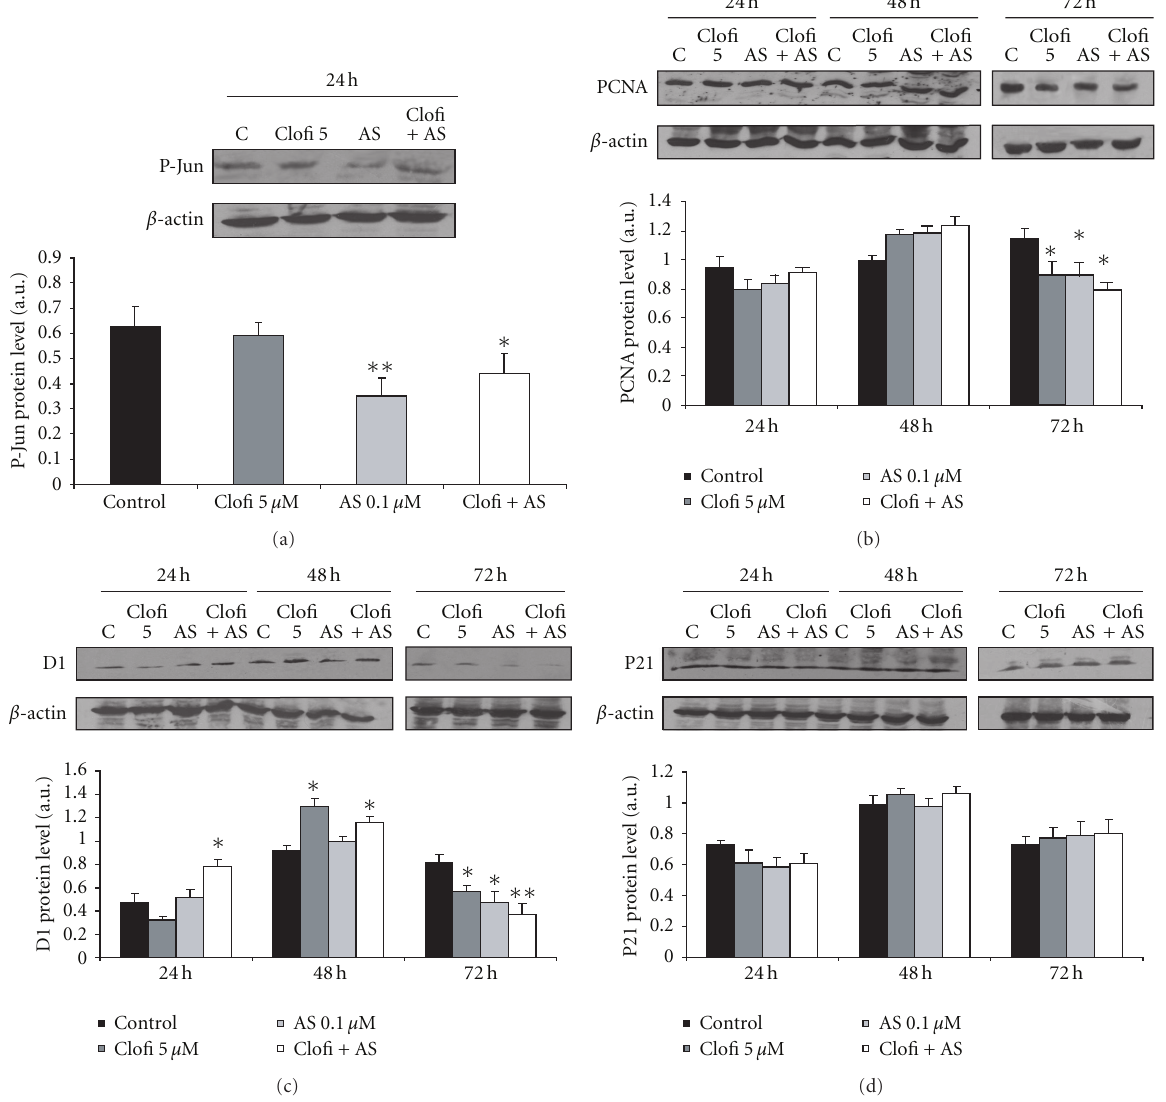
Figure 2: Proliferation-related protein expressions. (a) Determination of 0.1 μ M AS601245 e ff ect in reducing P-Jun expression; (b) time course of PCNA expression in CaCo-2 cells treated with 5 μ M clofibrate, 0.1 μ M AS601245, and the association of these two compounds (Clofi + AS601245); (c) time course of cyclin D1 expression in CaCo-2 cells treated with 5 μ M clofibrate, 0.1 μ M AS601245, and the association of these two compounds (Clofi + AS601245); (d) time course of p21 expression in CaCo-2 cells treated with 5 μ M clofibrate, 0.1 μ M AS601245, and the association of these two compounds (Clofi + AS601245). Graphics represent the relative quantification of protein products performed by densitometric scanning. Data were normalized by using the β -actin signal, expressed as arbitrary densitometric units, and are the mean ± SD of three separate experiments from three di ff erent preparations for each condition. Variance analysis: ∗ P < 0 . 05, ∗∗ P < 0 . 01 versus